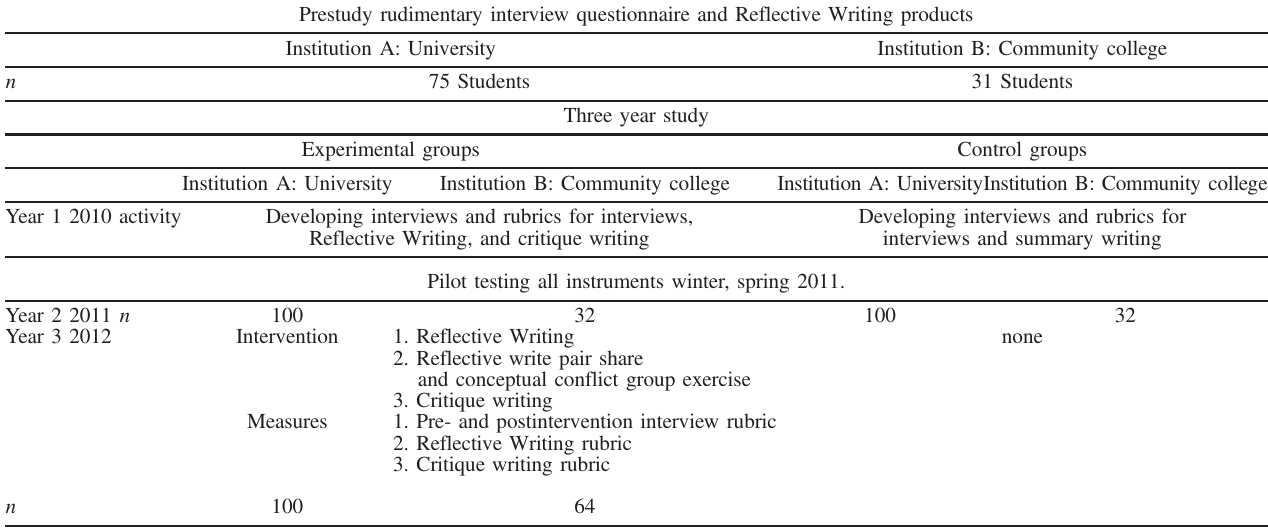
TABLE I. Overall design of the Montreal and Vancouver study across three years. Prestudy rudimentary interview questionnaire and Reflective Writing